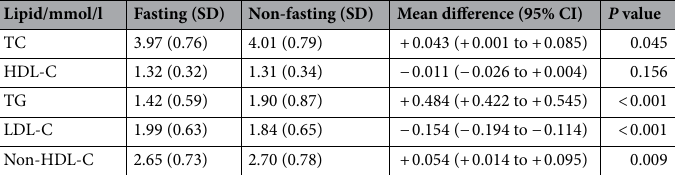
Table 2. Difference of fasting and non-fasting lipid readings using paired t-test.